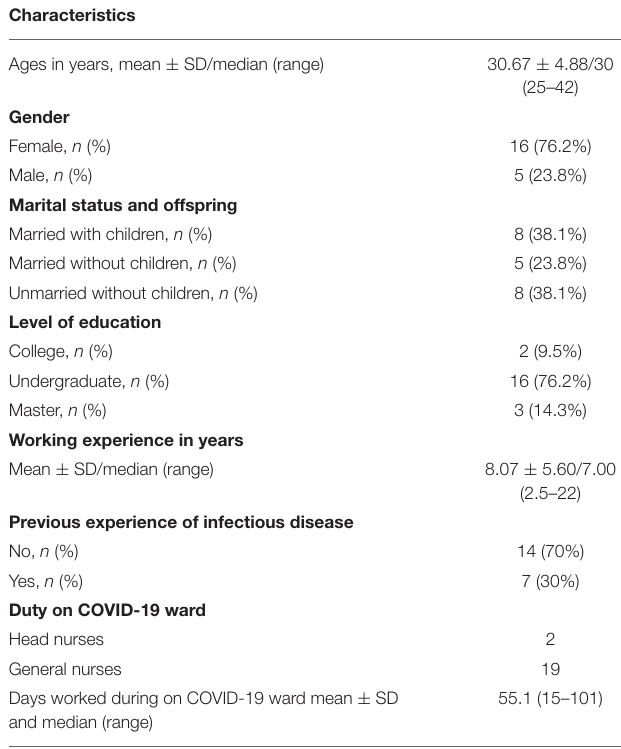
TABLE 1 | Characteristics of participants ( n = 21).